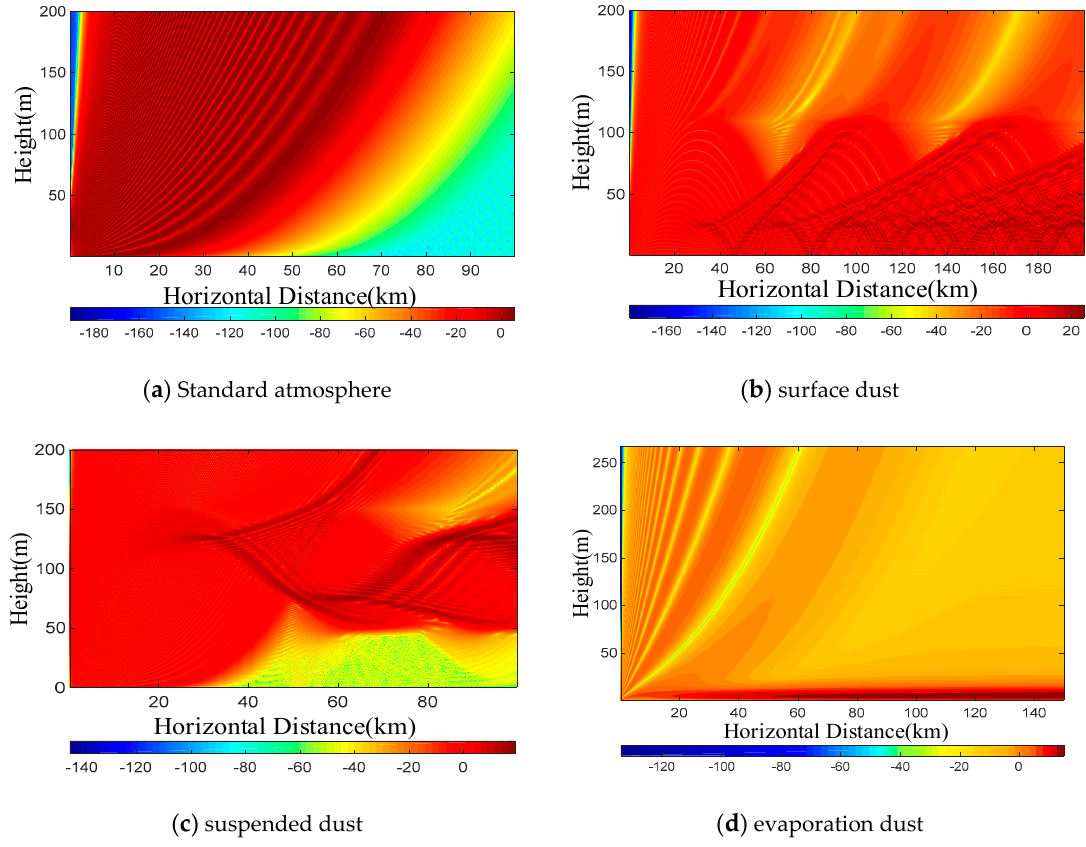
Figure 7. Propagation factors in different atmospheric environments: ( a ) shows the distribution of propagation factors under standard atmosphere; ( b ) is the distribution of propagation factors under surface dust conditions; ( c ) is the distribution of propagation factors under suspended dust conditions; ( d ) is the distribution of propagation factors under evaporation dust conditions.